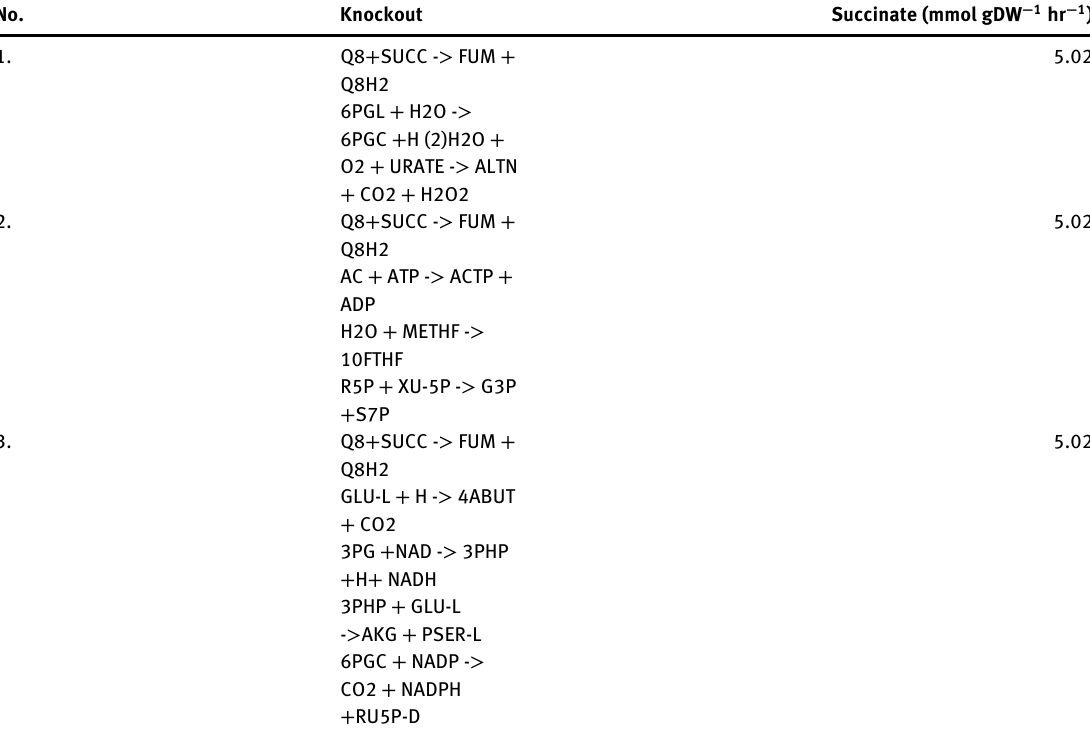
Table 3: List of gene knockout that identified by MOMAKnock for succinate production.